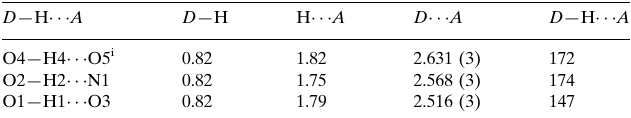
Hydrogen-bond geometry (A˚ , (cid:2)